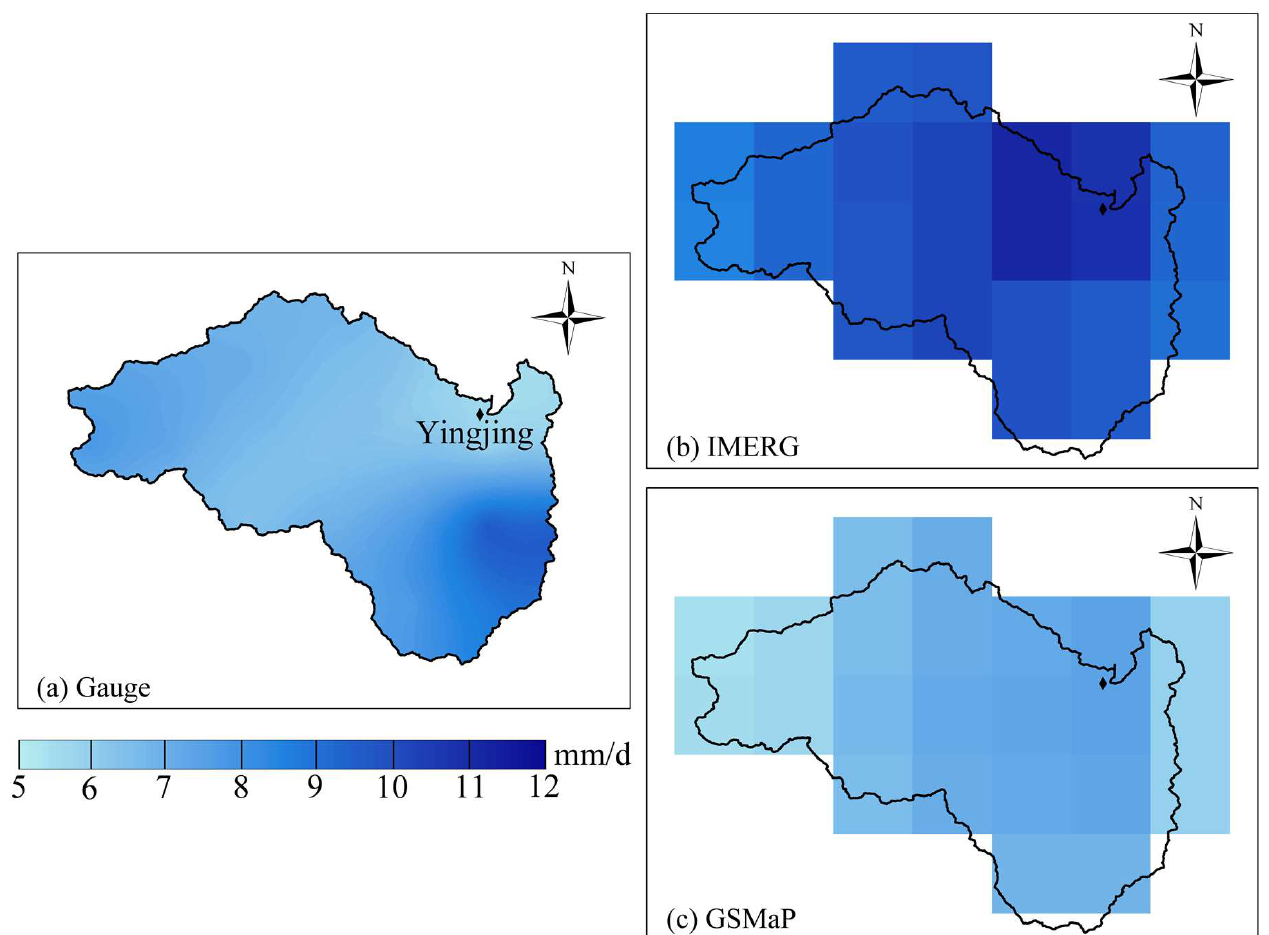
Figure 2. ( a ) Variation of rainfall amount of gauge and satellite products from 2014 to 2018. Tem- poral distribution of daily rainfall over the driest ( b ) and wettest ( c ) years.